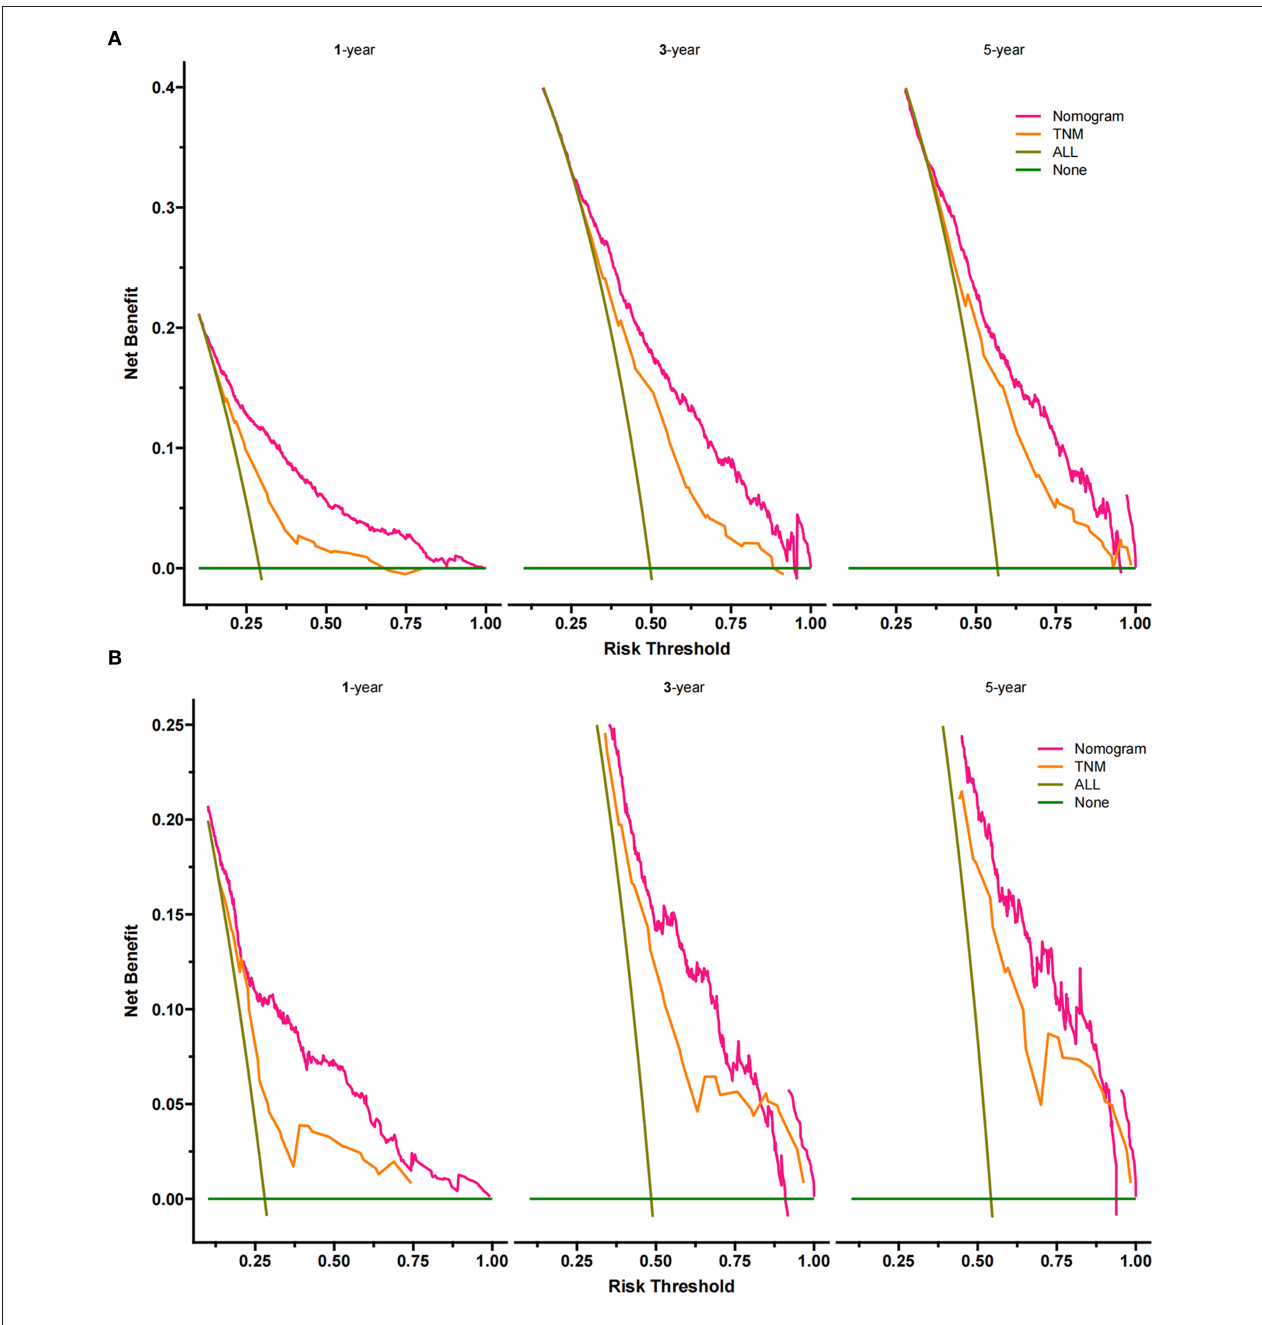
FIGURE 5 | Decision curves of the nomogram predicting CSS in the training set (A) and validation set (B) . The Y-axis represents net income, and the X-axis represents threshold probability. The green line means no patients died, and the dark green line means all patients died. When the threshold probability is between 25 and 90%, the net benefit of the model exceeds all deaths or